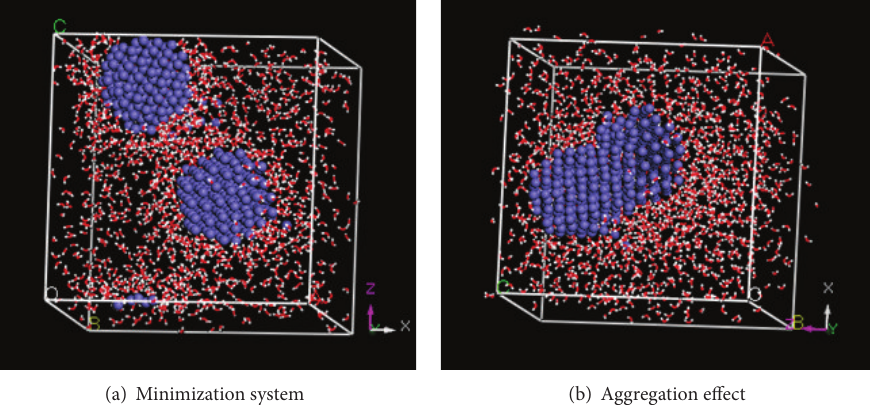
Figure 12: The conformations of minimization and aggregation effect of system 6.